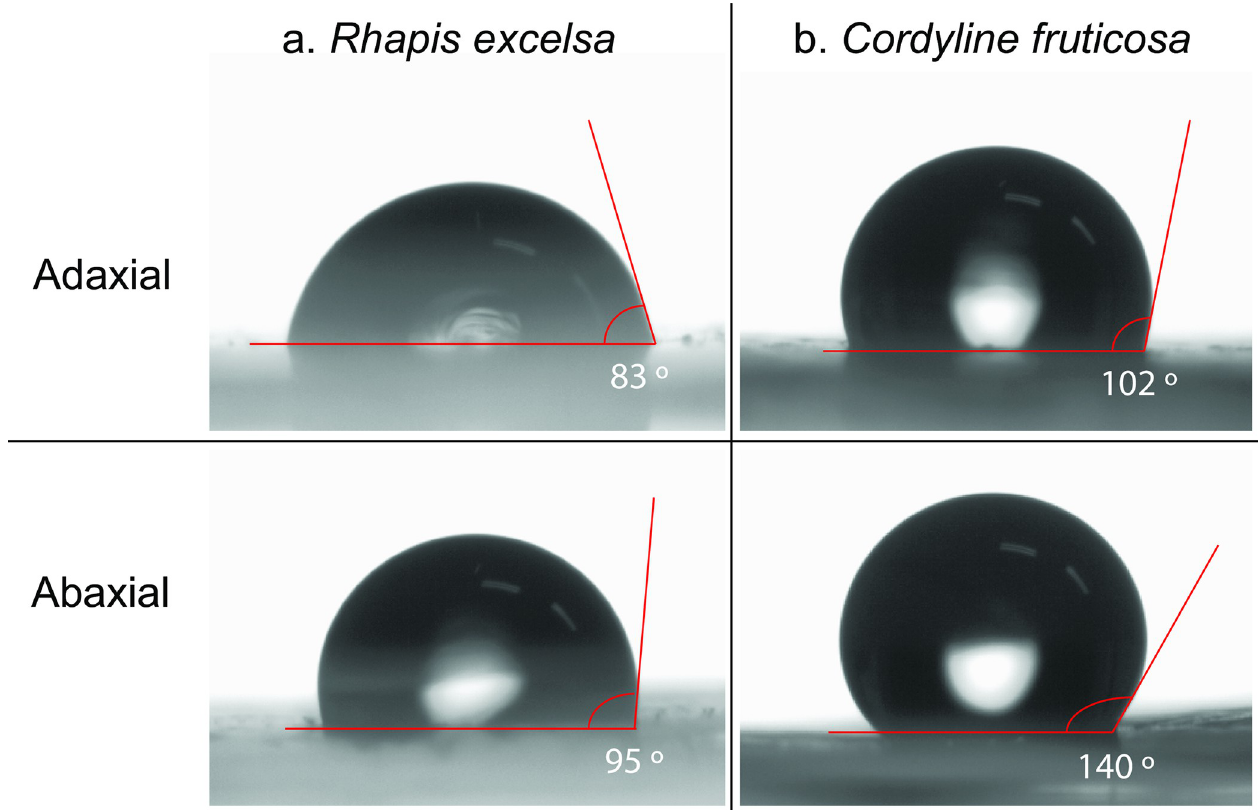
Fig 6. Surface wettability of leaf surfaces. The water contact angle was measured from images captured at orthogonal angle. The adaxial and abaxial leaf surfaces of (a) R . excelsa have contact angles of 83˚ and 95˚, respectively. The adaxial and abaxial leaf surfaces of (b) C . fruticosa have contact angles of 102˚ and 140˚, respectively. The abaxial surface is hydrophobic and repels water from its surface. The water droplet images were original images taken by Kenny J.X. Lau using the contact angle meter.